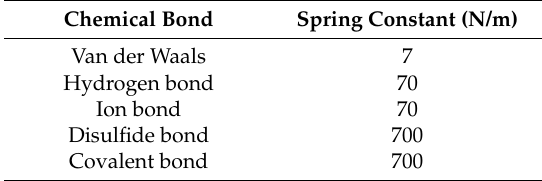
Table 2. Various spring constants assigned to each type of chemical bond in